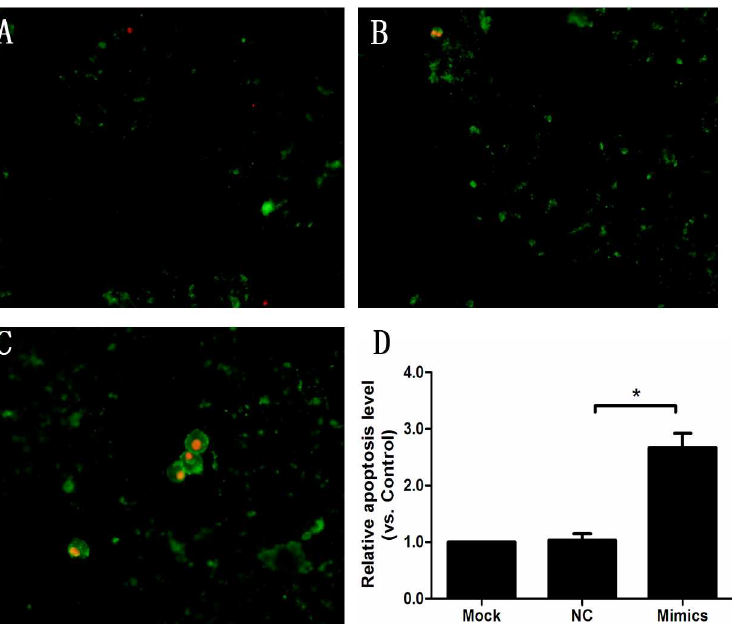
Fig 8. Overexpression of miR-139-5p enhanced INS-1 cell apoptosis by analysis with annexin V and PI staining (n = 3, * p < 0.05). Cells were treated with negativecontrol (B) or miR-139-5p mimics (C), incubated with annexinV and PI, and analyzedby confocalmicroscope. D: An estimate of the percentageof green- stainedcells. Results are representative of three independentexperiments. Cells were treated with Mock, NC (negative control) and Mimics for 24h. All experiments were performed in triplicate. Comparisons between groupswere by Student’s